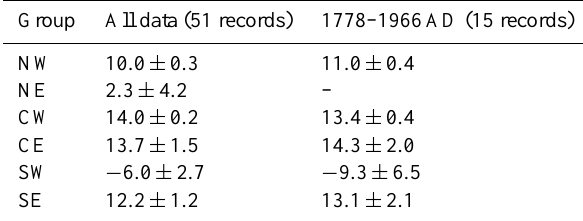
uncertainty in the least squares estimation of the C 1 values and